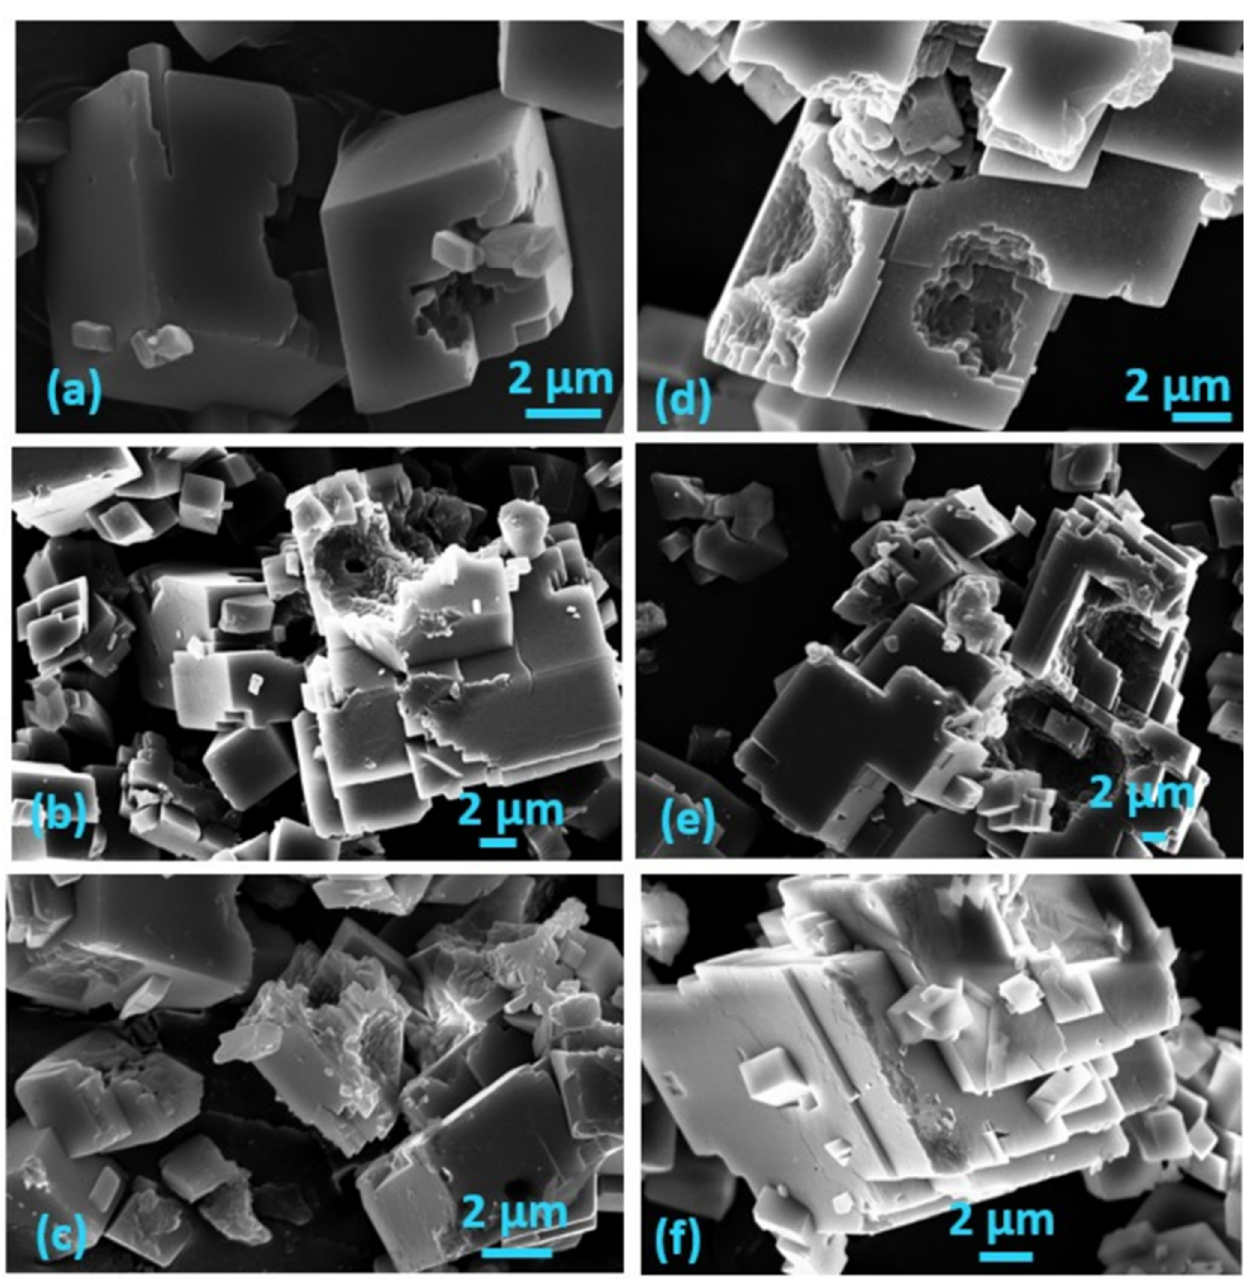
Figure 18. SEM photographs of calcite following equilibration with solutions containing Zn, Ni and Cd. ( a – c ) 0.2 μ M, ( d – f ) 10 μ M; 25 °C, 0.15 M of NaCl, pH 8.50.